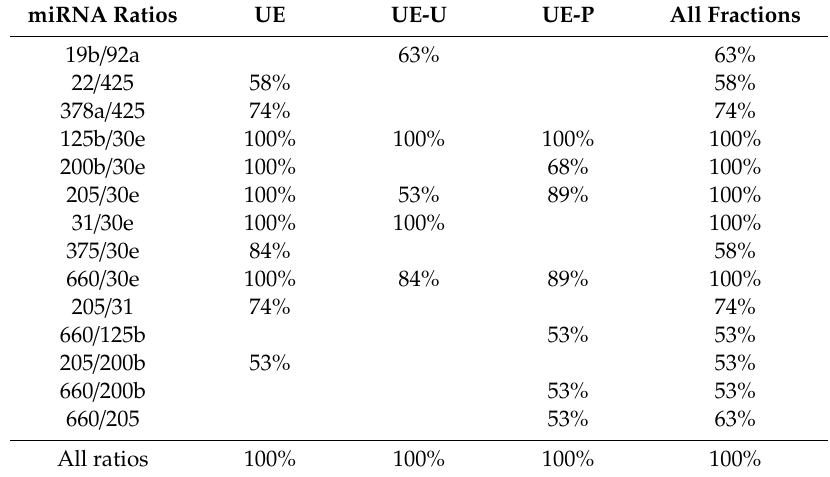
Table 8. Definitely not PCa. The percentage of HD and BPH patients divided from the control group (PCa).